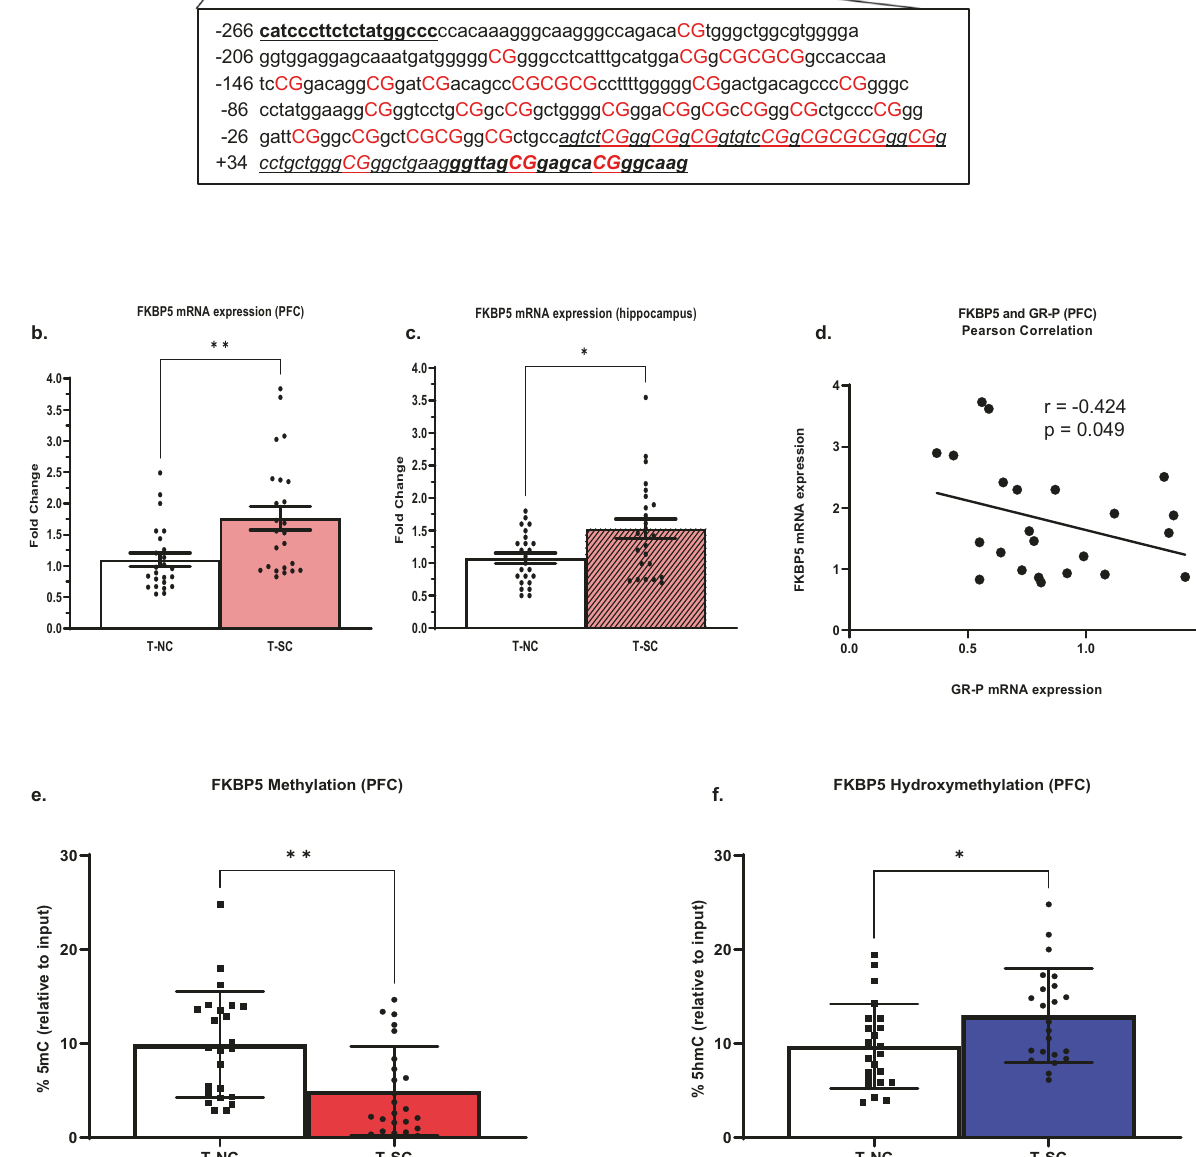
Fig. 3 Human FKBP5 mRNA expression, methylation, and hydroxymethylation analysis. a Schematic representation of the human FKBP51 gene proximal promoter region indicating Transcription start site (TSS). The analyzed region − 266 to + 73 (340 bp) which includes 39 CpGs (depicted in red uppercase letters). The numbering is relative to the TSS. Underlined/italicized letters indicate the exon, and bold/black letters indicate primers used for meDIP/hmeDIP-qPCR analysis. b Relative expression levels of FKBP5 mRNA in PFC (FC = 1.61, p = 0.0009), and c hippocampus (FC = 1.36, p = 0.02). Data are expressed as fold change (FC) ± SEM (error bars) after normalization to the geometric mean of internal controls and suicide-completers compared to normal control subjects. d Pearson ’ s correlation analysis of FKBP5 and GR-P mRNA levels in the PFC. e and f In the PFC, 5mC, and 5hmC levels across the TSS region of FKBP5 gene analyzed using meDIP and hmeDIP and presented as percent of input. e %5mC levels ( t = 3.22, p = 0.002) and f %5hmC ( t = − 0.25, p = 0.02). Results are expressed: %(5mC/5hmC) relative to input ± SD (error bars) measured across each region comparing suicide-completers (T-SC) to normal-control (T-NC) subjects. N = 24/24. * p < 0.05, ** p <